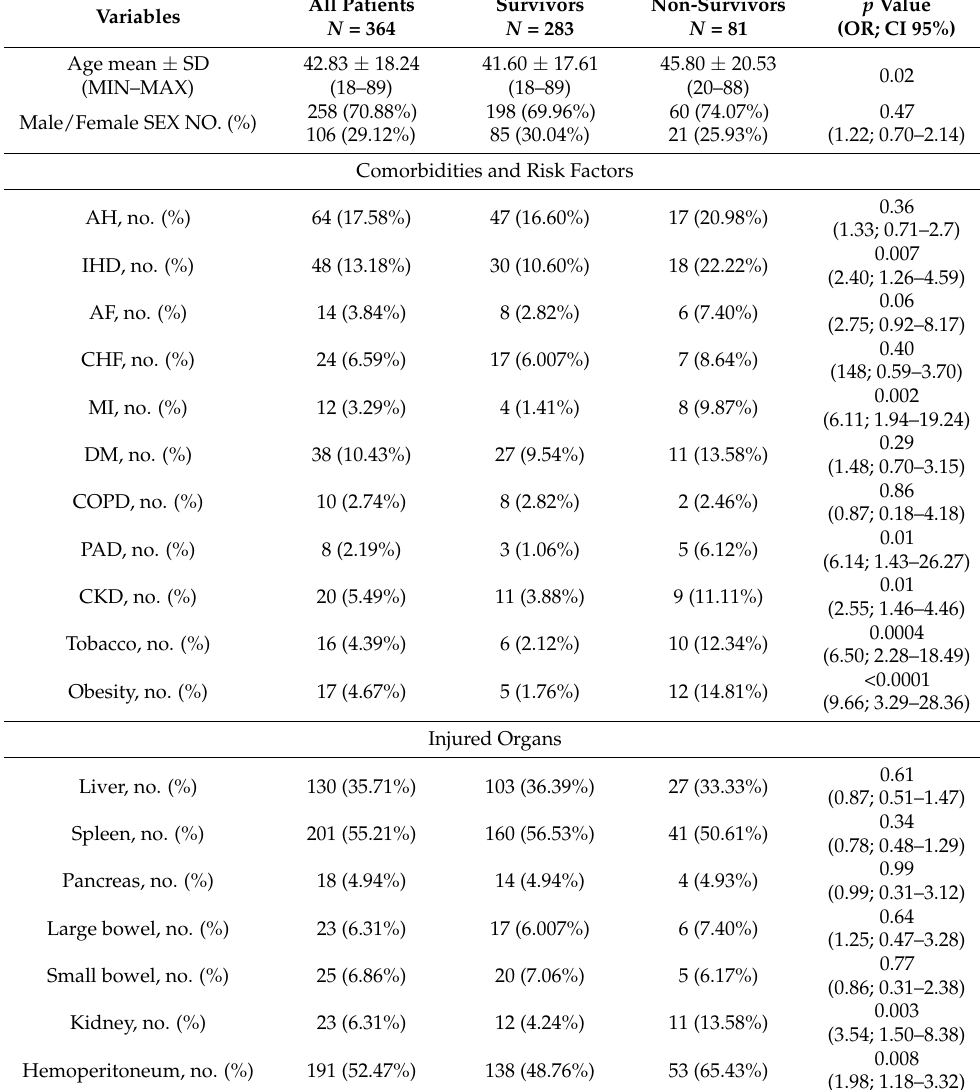
Table 1. Demographic information, comorbidities, risk factors, damaged organs, laboratory results, and outcomes were collected for all patients, and the two categories were separated based on poor